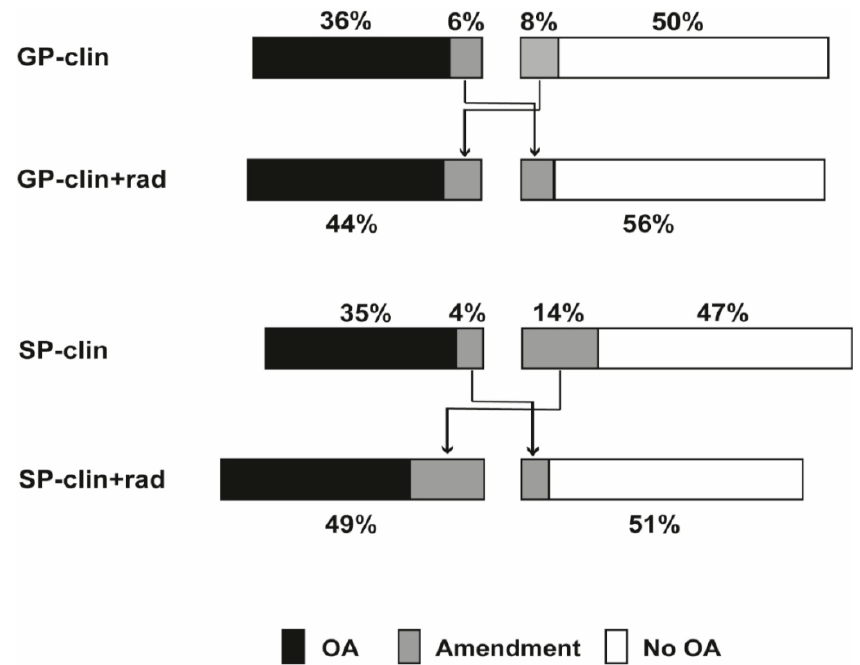
Figure 2. General practitioner (GP) and secondary care physician (SP) diagnoses based on clinical data (clin), clinical combined with radiographic data (clin + rad); OA, osteoarthriti.